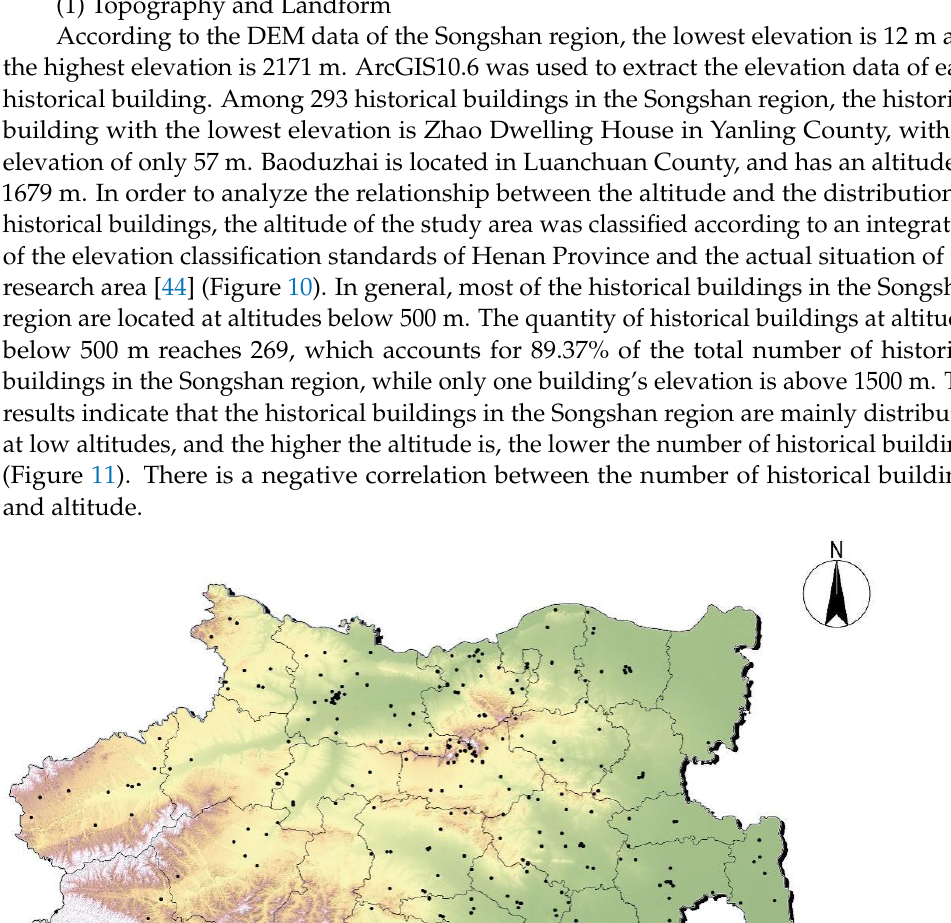
Figure 11. Quantitative distribution of historical buildings in the different altitude ranges.